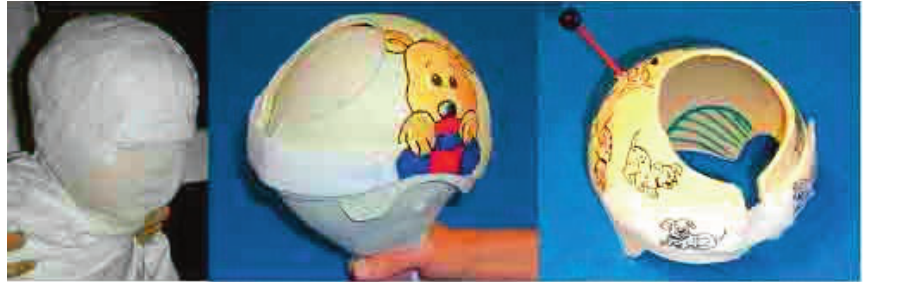
Figure 2 Plaster of Paris im- ression from the in- fant’s head covered with a jersey sock.